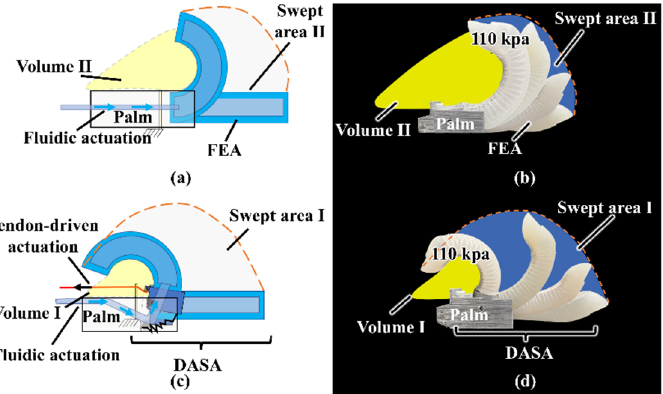
Figure 9. Bending trajectory comparison of the DASA finger and FEA finger. ( a ) FEA finger bending trajectory schematic. ( b ) An FEA finger prototype bending trajectory. ( c ) DASA finger bending trajectory schematic. ( d ) A DASA finger prototype bending trajectory.